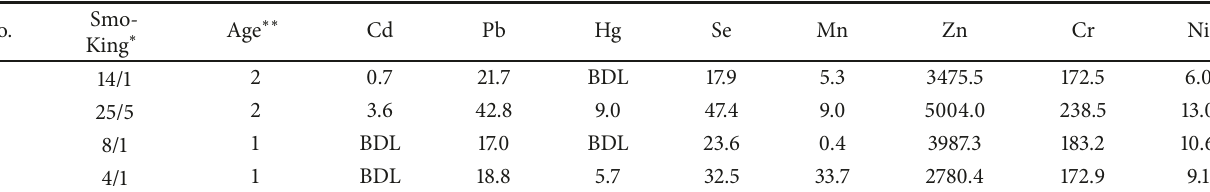
∗ Smoking; period of smoking (y)/rate of smoking (number of pipes per day), ∗∗ Age; 1= ≤ 25, 2= 26-40 y